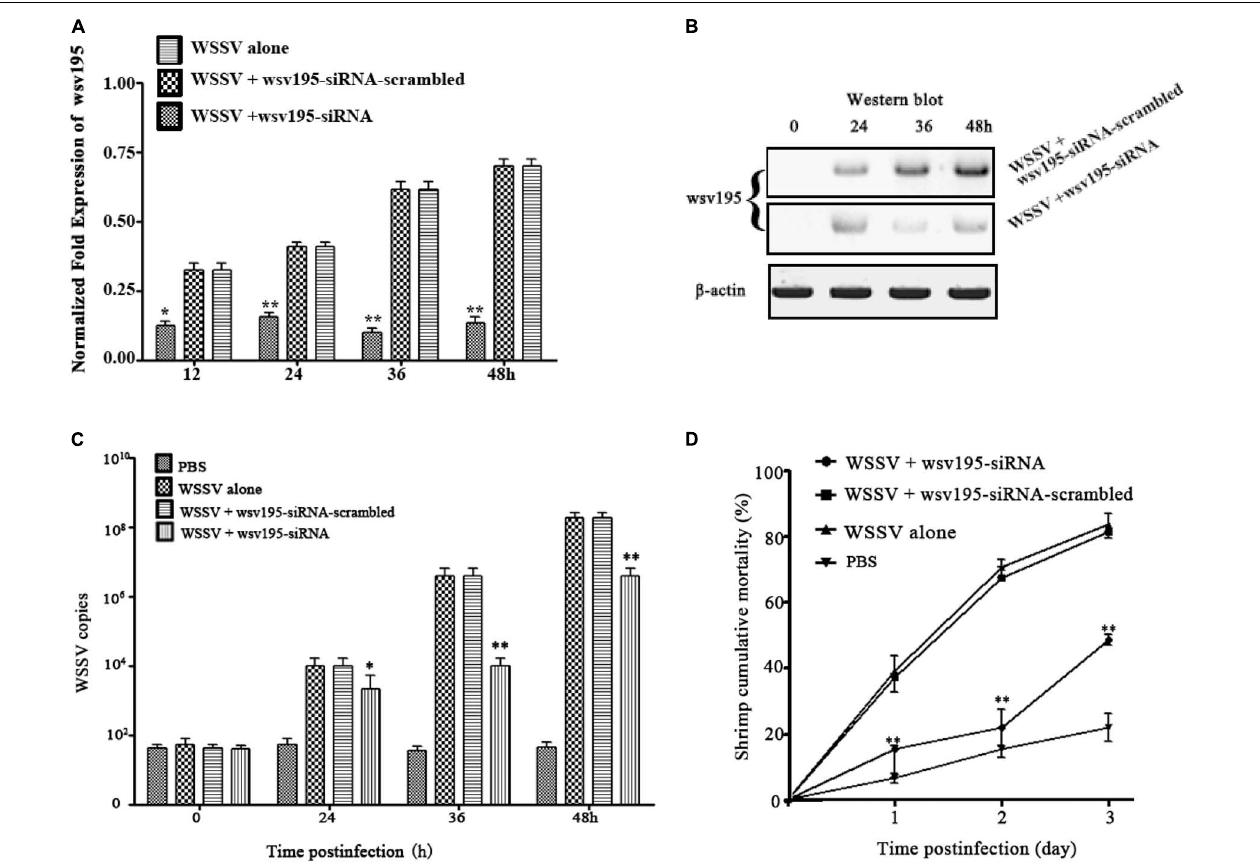
FIGURE 4 | Impact of Type B WSSV in the virus population on virus infection. (A) Silencing of wsv195 encoded by Type B WSSV in WSSV-infected shrimp. Wsv195-siRNA and WSSV were coinjected into shrimp. As a control, wsv195-siRNA-scrambled was included in the assay. At different time points post infection, the wsv195 mRNA level was examined using quantitative real-time PCR. The number indicates the time post infection. (B) Western blot analysis of wsv195-silenced shrimp. The treatments are indicated on the right. β -Actin was used as a control. (C) Effects of wsv195 silencing on virus replication in shrimp. The WSSV copy numbers in shrimp treated with wsv195-siRNA were quantified by real-time PCR. PBS, WSSV alone and wsv195-siRNA-scrambled were used as controls. (D) Influence of wsv195 knockdown on WSSV-infected shrimp mortality. All the experiments were biologically repeated for three times. In all panels, the statistical significance between treatments is indicated with asterisks (* p < 0.05; ** p <